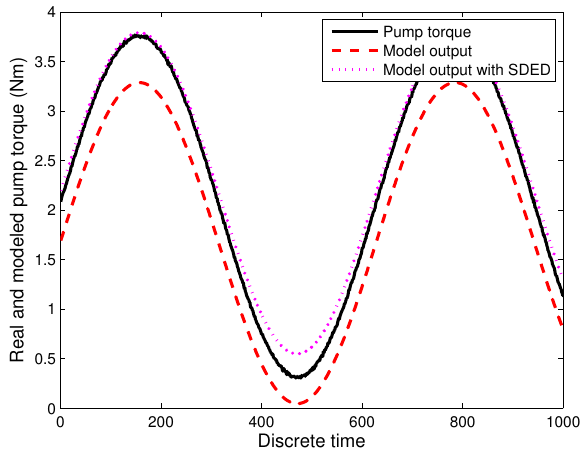
Figure 9. Real and modeled pump torque estimated with and without Sequential D-optimum Experimental Design